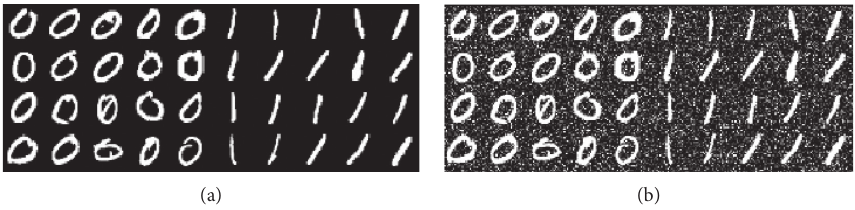
Figure 15: Example of original “0” and “1” images and images with noise.